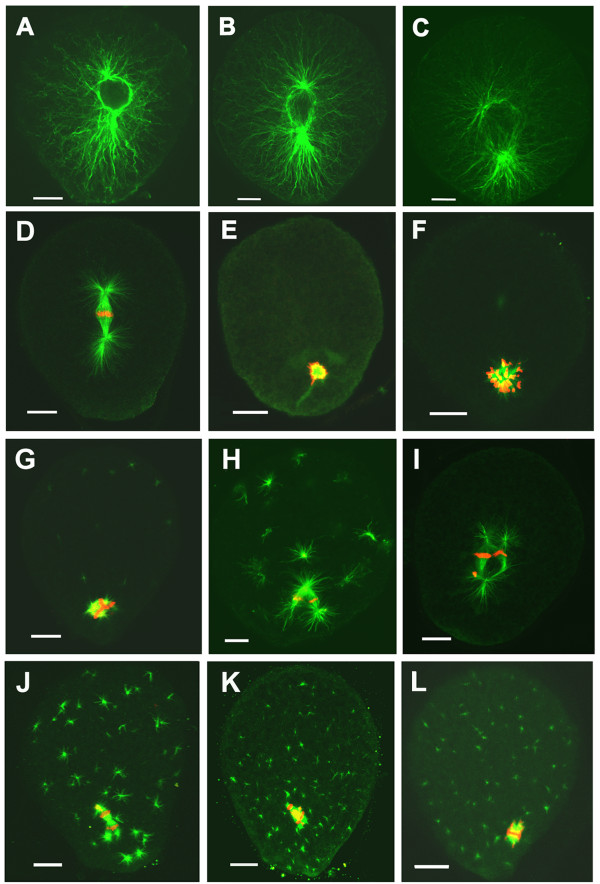
Monastrol and STLC treatment of S. compressa zygotes. (A-C) Zygotes were not sensitive to monastrol treatment during interphase (16 h AF); (A) 0.2% DMSO (B) 25 μM monastrol, (C) 50 μM monastrol. Note that the interphase zygotes in B and C exhibit elongated nuclei, indicating that they developed slightly faster than the control zygote in A. However, differences in developmental timing between treatments were not routinely observed. (D-F) Formation of monasters in mitosis (24 h AF); (D) 0.2% DMSO, (E) 25 μM monastrol, (F) 5 μM STLC. (G-I) Multipolar spindles (24 h AF); (G) 25 μM monastrol, (H) 50 μM monastrol, (I) 0.5 μM STLC. (J-L) Cytaster formation; (J) 25 μM monastrol (24 h AF), (K) 50 μM monastrol (24 h AF), (L) 100 μM monastrol (48 h AF). Cytasters were observed scattered throughout the cytoplasm. Hours in parentheses indicate times at which zygotes were fixed. MTs are depicted in green, condensed chromatin is depicted in red, and overlap between MTs and condensed chromatin is depicted in yellow. Median optical sections, 10–20 μm in total thickness, are shown. Scale bars equal 10 μm.